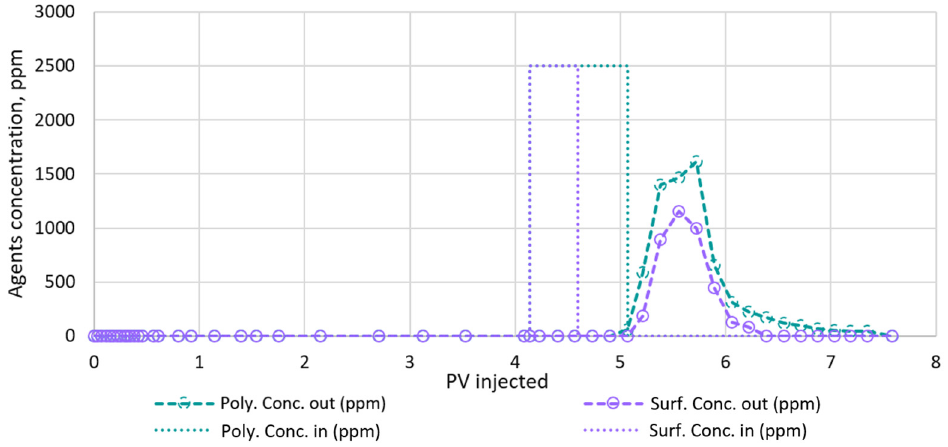
Figure 2. Agent concentrations at sample inlet and outlet. Table 1. Agent injection modes (PV—pore volumes).